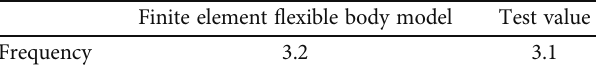
Table 5: Natural frequencies between the simulation model and experiment data